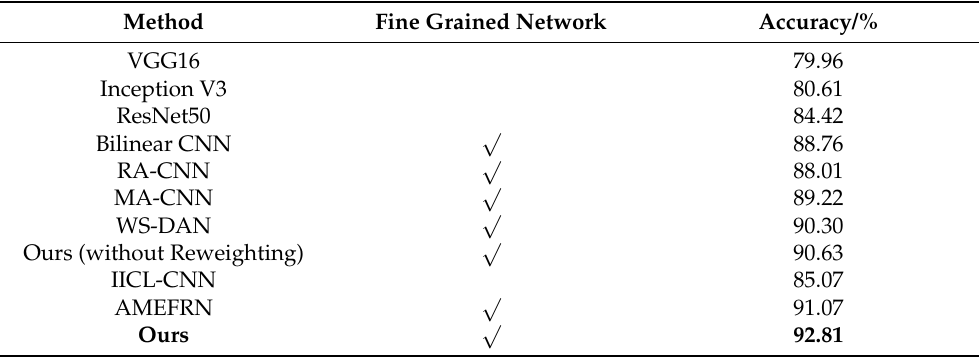
Table 7. Compare with other state-of-the-art methods on ORSC-15 dataset. A check mark in the second column indicates that the method is a fine-grained method. Bold values indicate best performance.